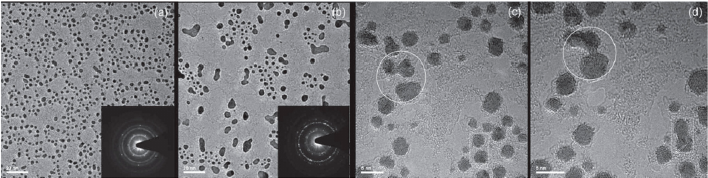
Figure 17. ( a , b ): Transmission Electron Microscopy images of 0.2 nm Au evaporated onto hydrogenated and pristine graphene (scale bar: 20 nm). The corresponding diffraction patterns are shown as insets; ( c , d ) Images of Au evaporated onto hydrogenated graphene, taken in a sequence of scans, and showing the Au clusters merging by coalescence as indicated by the solid circles and dashed rectangles (scale bar: 5 nm). Reproduced from Reference [66] with permission from Wiley.